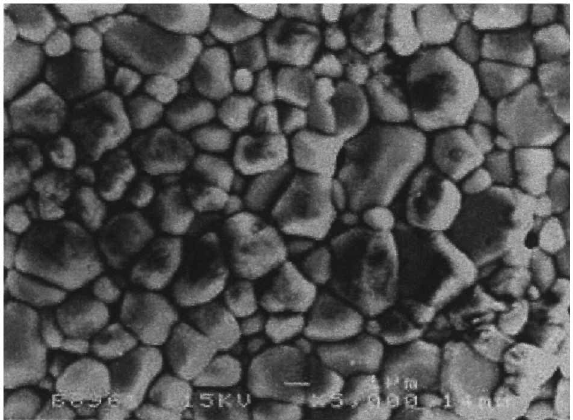
FIGURE 9 Microstructure of the SRS-derived SrSnO 3 sample sintered at 1350 (cid:1) C with